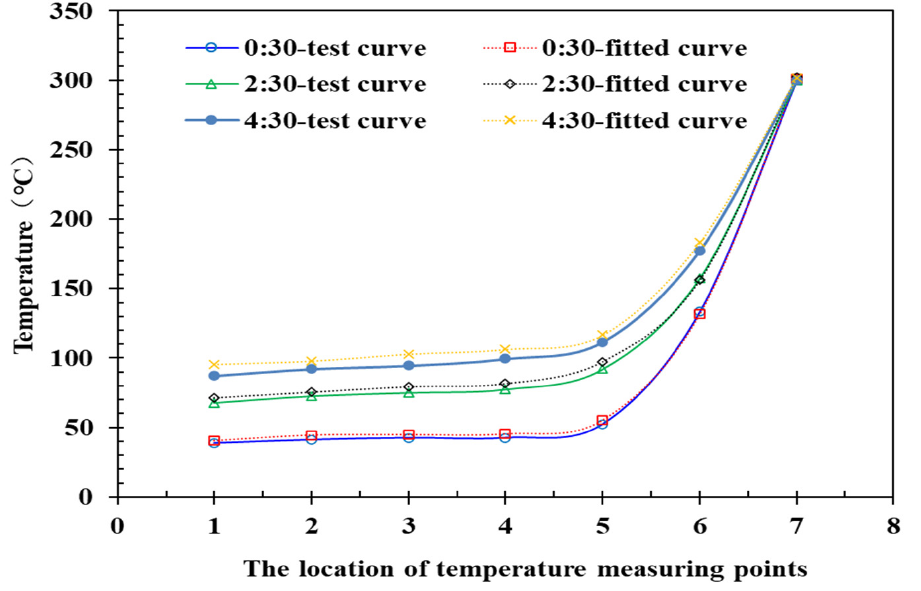
Figure 6. Temperature fitting results of saturated CO 2.